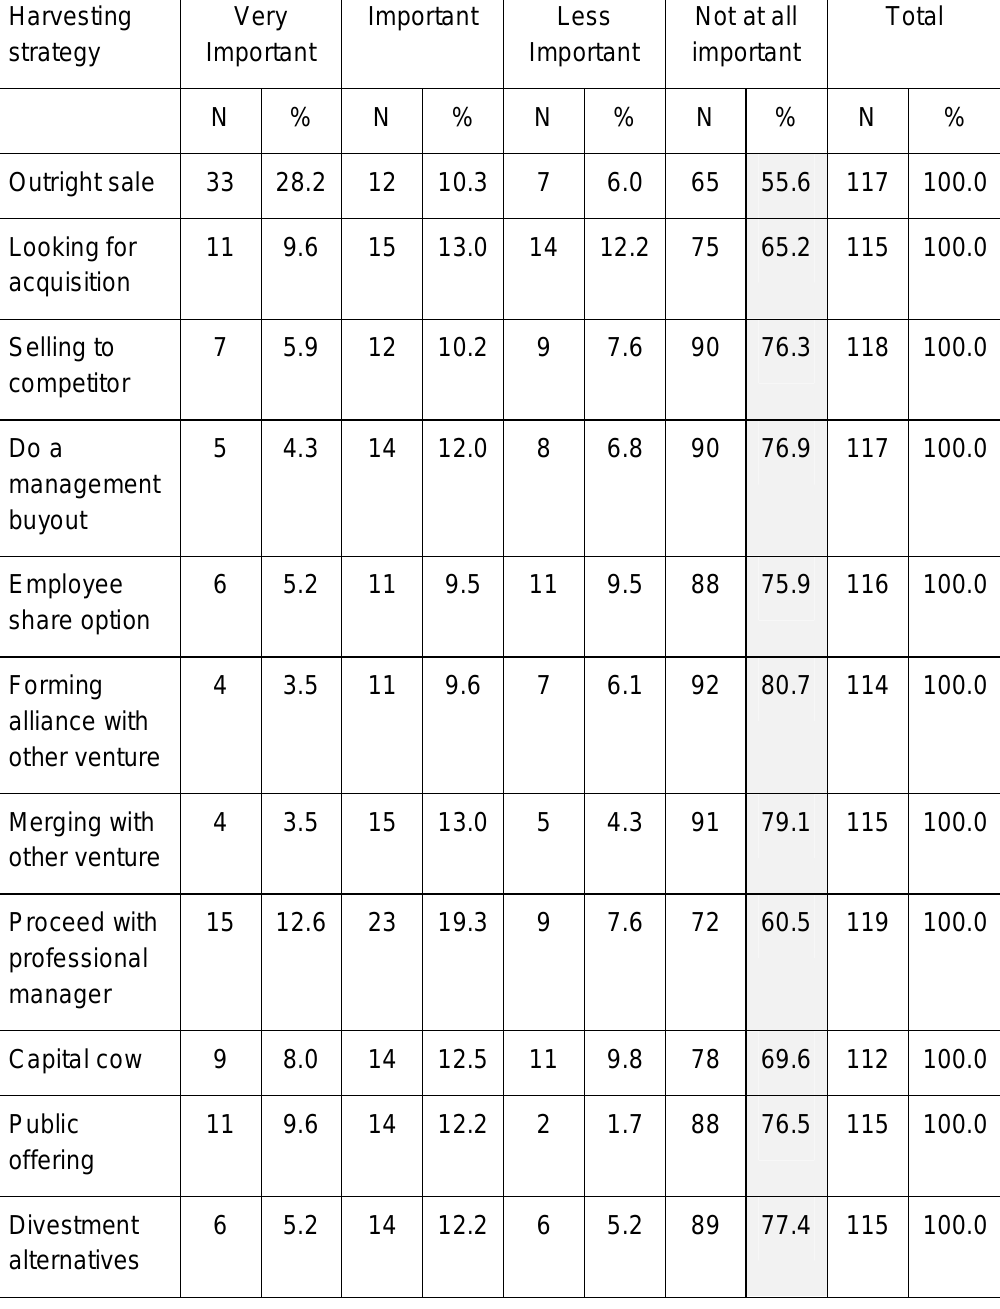
Table 2: Respondents’ awareness of the importance of harvesting strategies Harvesting